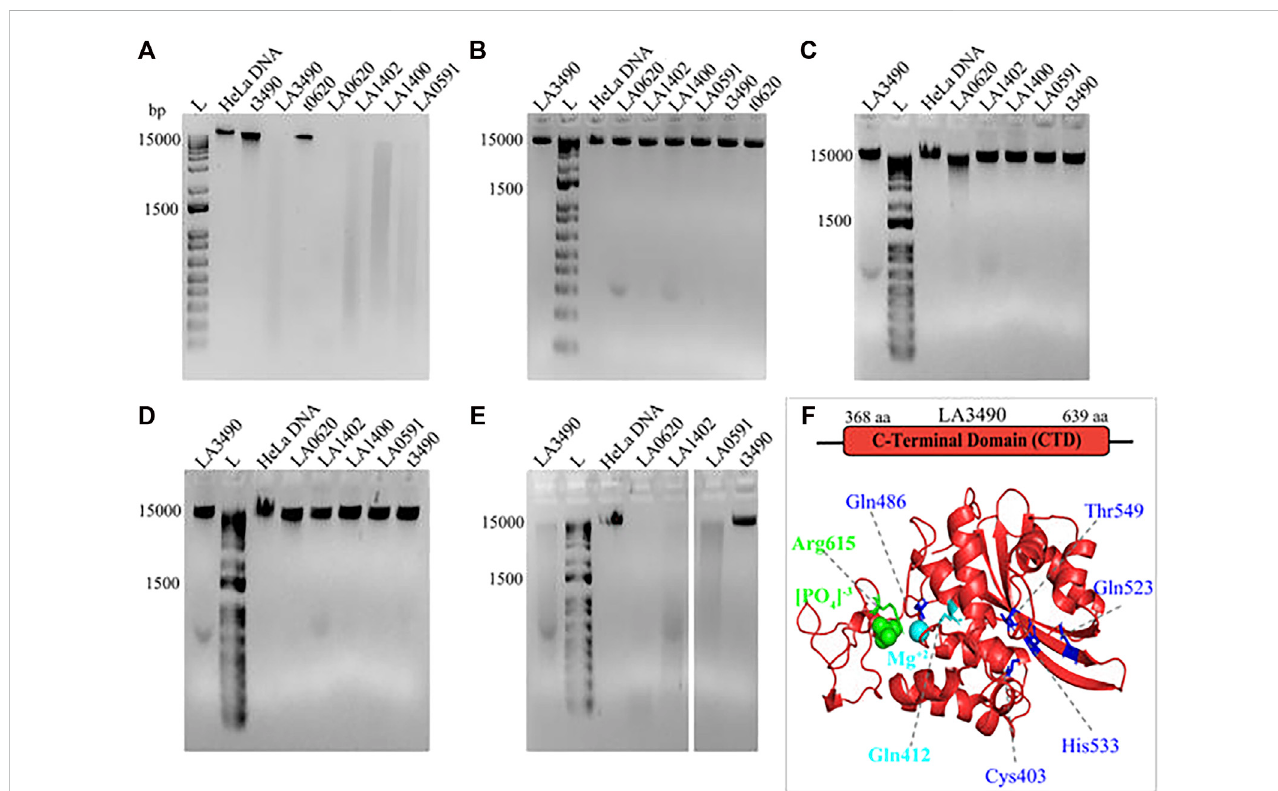
FIGURE 8 Demonstrating the effect of divalent cations on DNase activity of VM proteins. HeLa DNA (150 ng) were incubated with 30 nM of puri fi ed soluble recombinant VM proteins (t3490, LA3490, LA0620, LA1402, LA1400, and LA0591) in TM buffer (10 mM Tris pH-7.4) containing 3 mM MgCl 2 (A) , absence of (divalent cation) MgCl 2 (B) , presence of 2 mM ZnCl 2 (C) , presence of 3 mM CaCl 2 (D) , and presence of CaCl 2 + 3 mM MgCl 2 (E) for 30 min and samples were subjected to 1% agarose gel electrophoresis. The DNase activity by VM proteins is indicated by smearing and disappearance of DNA, whereas negative controls such as t3490, t0620 which does not encode for the functional CTD, had no such effect. (F) Docking study with CTD of LA3490 showing phosphate (greencolorspheres)andmagnesiumion(cyancolorsphere)interactionwithArg615(bindingenergy − 2.58kCal/mol)andGln412(bindingenergy − 0.95kCal/ mol) respectively. The residues having high binding energy shown in blue